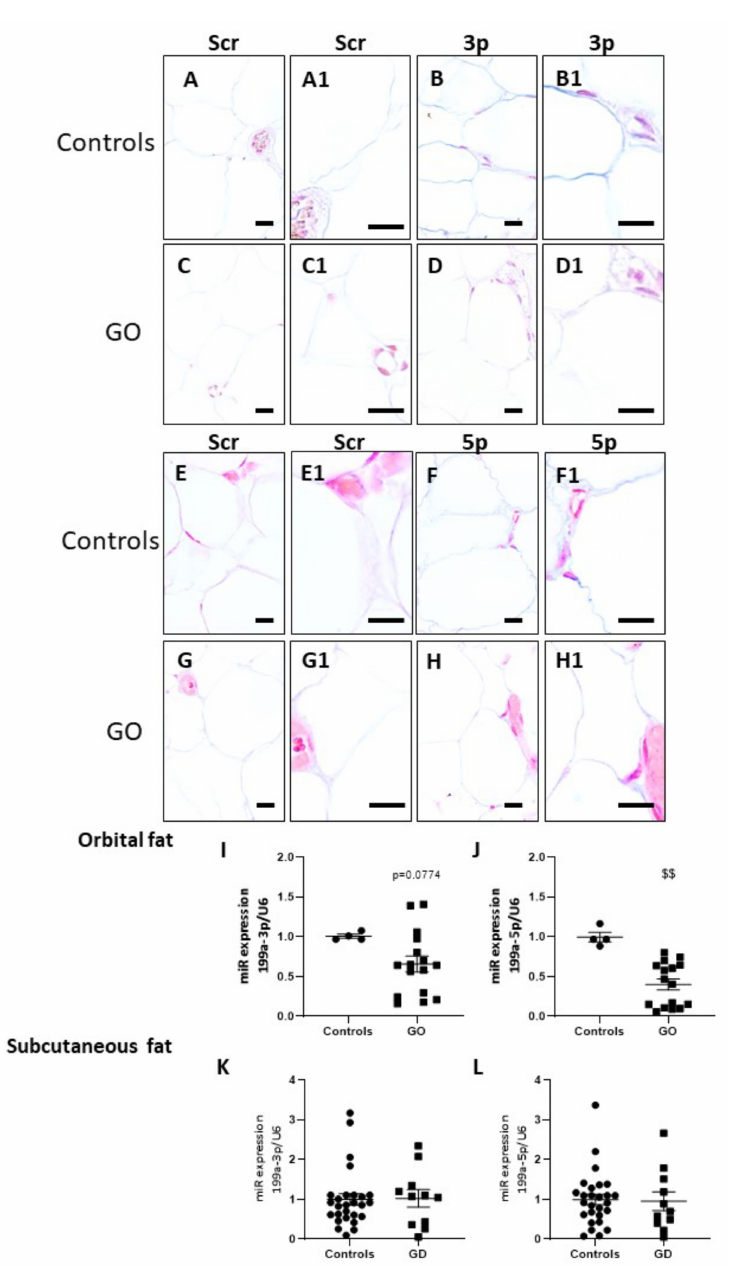
Figure 6. miR-199a family is downregulated in GO orbital adipocytes. In situ hybridization of LNA TM probe Scramble-miR ( A , C , E , G ), of miR-199a-3p ( B , D ) and of miR-199a-5p expression ( F , H ) in controls and GO orbital fats. Note that control adipocytes expressed both miRs, whereas a very low signal was observed in GO orbital adipocytes ( A1 – H1 ). Scale bars = 10 µ M. qRT-PCR confirmed a decreasing trend of miR-199a-3p and a significant reduction of miR-199a-5p in GO orbital fats ( I , J ). No modification of miR199a family profile expression was observed in GD subcutaneous adipose tissues compared to controls ( K , L ). The data were normalized with the data of U6 snRNA. Data represent the mean ± SEM for 4 controls and for 16 GO orbital fats and for 27 controls and 11 GD subcutaneous adipose tissues. $$ p < 0.01 compared to